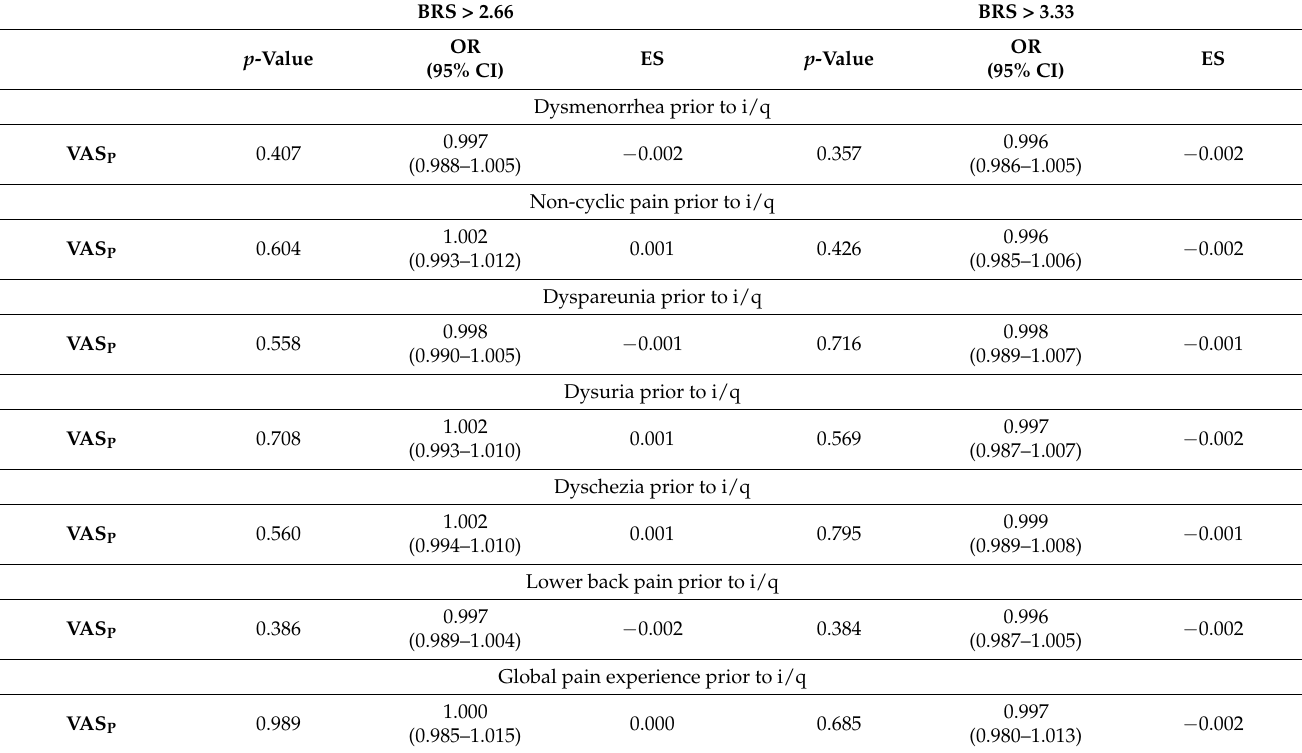
Table 5. Influence of pain intensity on resilience (univariate logistic regression analysis). BRS > 2.66 BRS >